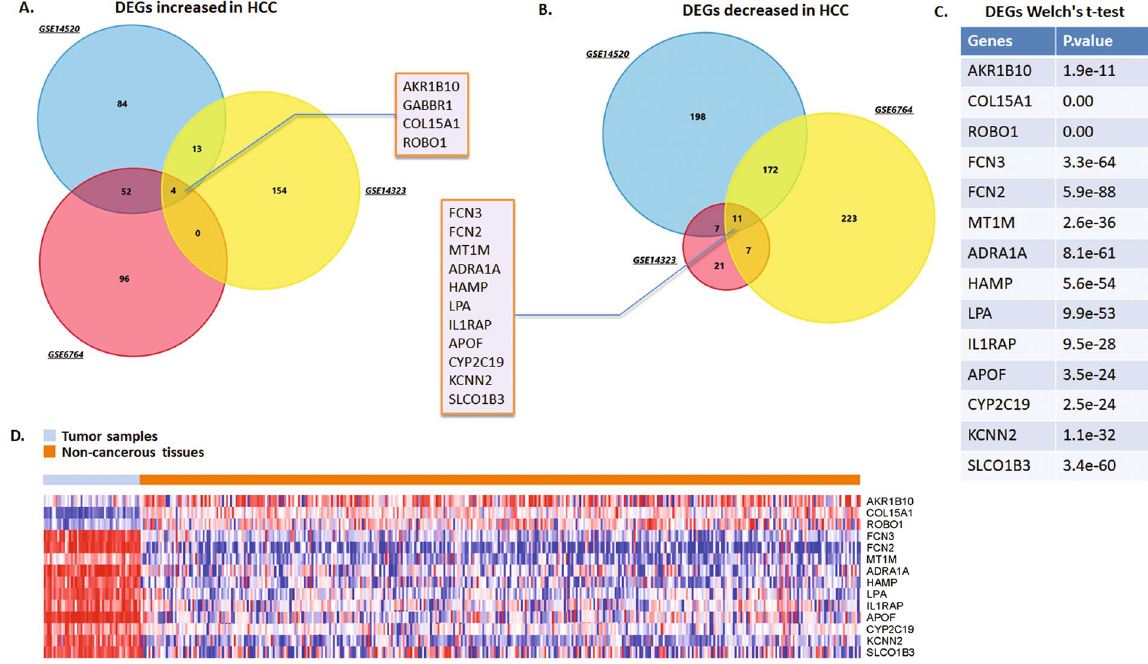
Figure 1. DEGs identified from NCBI GEO datasets ( A ) Venn chart of the over-expressing genes in GSE14520, GSE14323 and GSE6764 liver cancer datasets, which overlapped according to the analysis of FunRich software. Four DEGs extremely over-expressed in the three datasets were selected, including AKR1B10, GABBR1, COL15A1, AKR1B100. ( B ) Venn chart of the decreasing genes in three live cancer datasets. Eleven DEGs extremely decreased were selected, including FCN3, FCN2, MT1M, ADRA1A, HAMP, LPA, IL1RAP, APOF, YP2C19, KCNN2 and SLCO1B3. ( C ) The identified overlapped 15 DEGs from microarray were further tested in TCGA mRNA expression from RNAseq data by Welch’s t-test with P < 0.05 as the cutoff for tumor and normal samples comparison. ( D ) Heatmap generated through TCGA database exploration and data mining. Expressions of the 15 DEGs above were presented by hot spots with gradient from red as high expression to blue as low